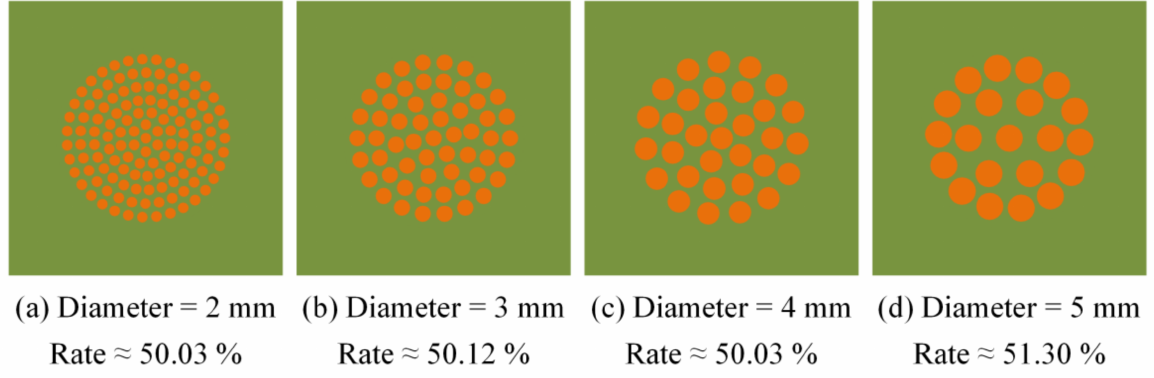
Figure 6. Anti-icing specimens with different silicone rubber